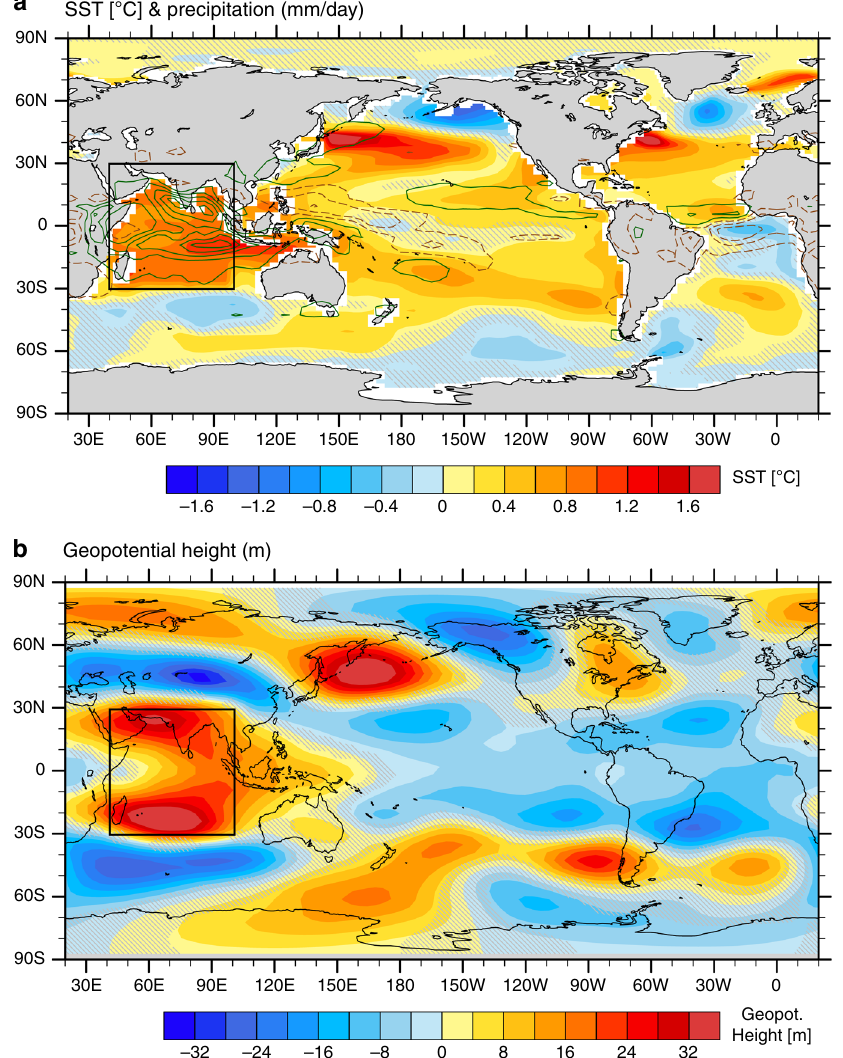
Fig. 4 Global climate response to tropical Indian Ocean (TIO) warming. Anomalies in ( a ) sea surface temperature (SST; units: °C) and precipitation (contours; 0.6 mm per day interval); light green and brown contours represent positive and negative precipitation anomalies starting from 0.3 mm per day and − 0.3 mm per day, respectively, and ( b ) geopotential height (units: m; zonal mean removed) at level 193 of CESM ’ s hybrid vertical coordinate, close to 200 hPa. Anomalies are averaged within the fi rst 40 years of the integrations (i.e. the initial response) for the TIO + 1C experiment relative to the PI simulation. Gray hatches highlight the areas of lower statistical signi fi cance ( p -values of Student ’ s t test above 0.05). The box over the Indian Ocean indicates the region where SST anomalies are imposed in the perturbation